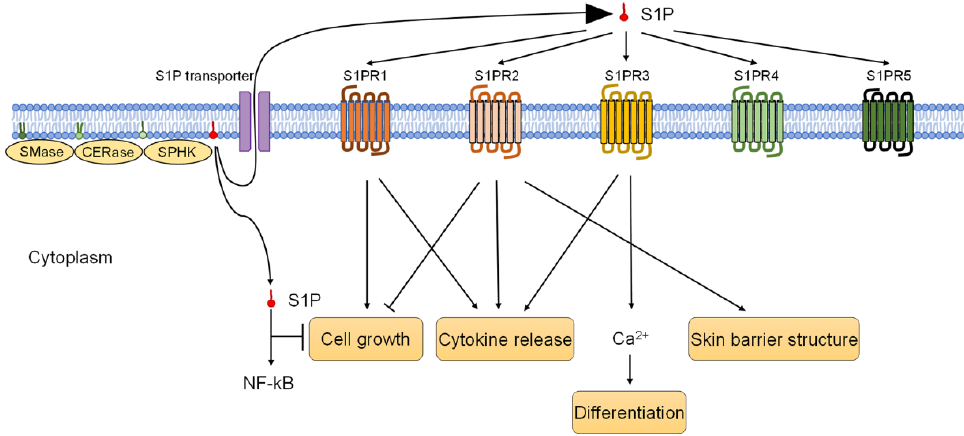
Figure 3. S1P and S1P-S1PR pathways of keratinocytes. Keratinocytes express all five S1P receptors, S1PR1–S1PR5. While S1PR1 activates cell growth, S1PR2 inhibits keratinocyte cell growth and mediates skin barrier structure. S1PR1, S1PR2, and S1PR3 trigger cytokine release. S1PR3 promotes keratinocyte differentiation.